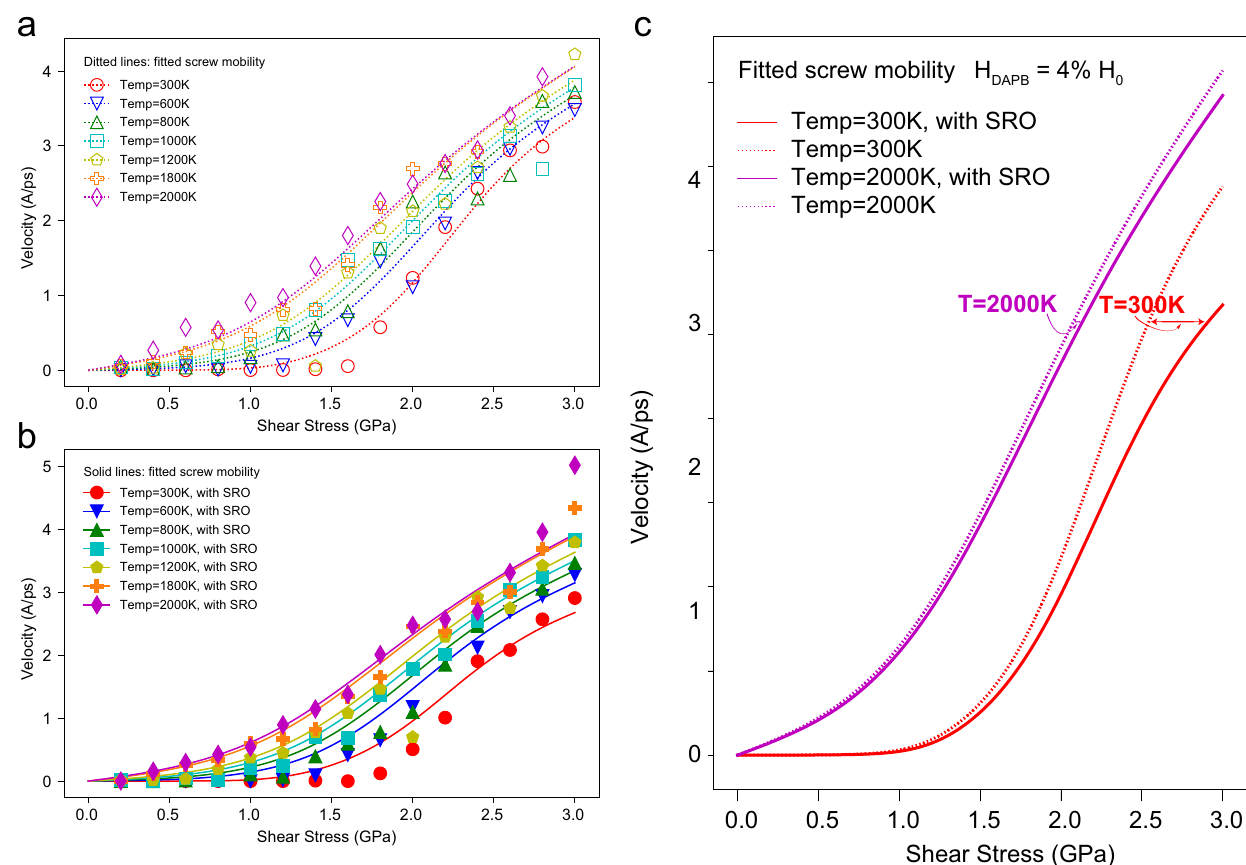
Fig. 4 Fitted screw-dislocation mobility model and the in fl uence of thermal entropy on the SRO-strengthening effect. a Velocity vs. stress results over a range of temperatures for the screw dislocation in the RSS sample. The open symbols are the simulation data, and the dashed lines are the fi ts of the phenomenological model described in the text. b Velocity vs. stress results over a range of temperatures for the screw dislocation in the systems with SRO. The solid lines are the fi tted screw-dislocation mobility based on the phenomenological model with the Δ H DAPB term included in the kink-pair formation free energy. c The in fl uence of temperature on the SRO strengthening of the screw dislocation. Solid lines represent the fi tted model results for the sample with SRO and the dashed lines represent the fi tted model for the RSS sample. The strengthening effect due to SRO attenuates when temperature increases from 300 to 2000